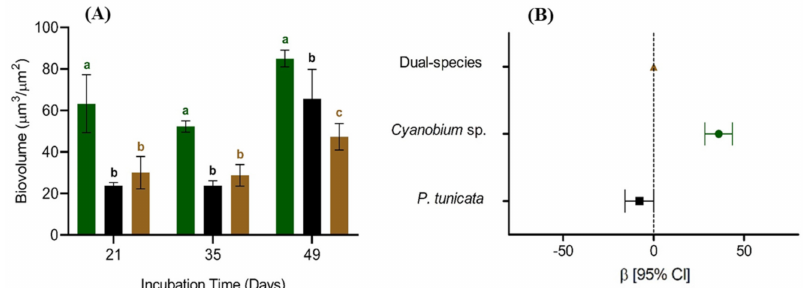
Figure 2. ( A ) Biovolume of single- and dual-species biofilms established on gel-coated glass surfaces at days 21, 35, and 49: (cid:4) — Cyanobium sp. LEGE 10375, (cid:4) — Pseudoalteromonas tunicata, and (cid:4) — Pseudoalteromonas tunicata–Cyanobium sp. LEGE 10375. Letters were assigned in alphabetic